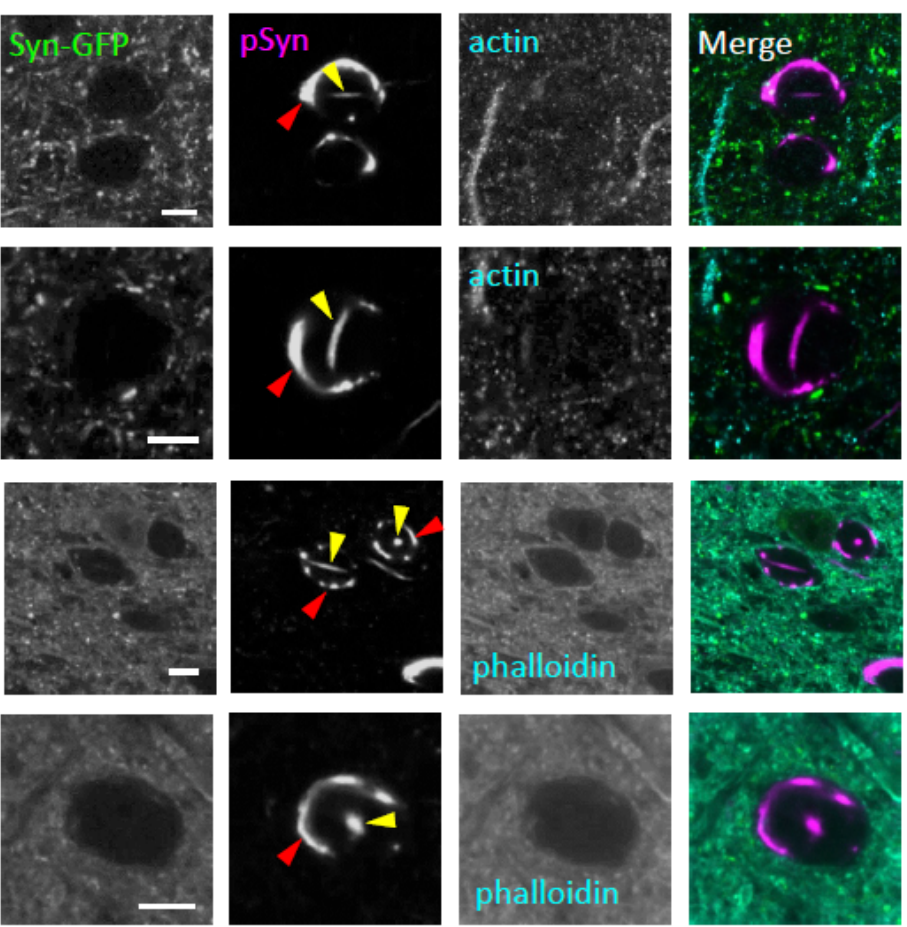
Figure 4. Intranuclear alpha-synuclein aggregates in neurons bearing somatic Lewy pathology do not have an actin component. Confocal imaging in fixed tissue from PFF-injected Syn-GFP transgenic animals induced to form Lewy pathology shows four examples of somatic (red arrowhead) and intranuclear (yellow arrowhead) inclusions (each row a different cell) imaged for endogenous GFP fluorescence (Syn-GFP), with a serine-129 phospho-synuclein antibody (pSyn), an actin-specific antibody ( top two rows ), and the actin-binding dye phalloidin ( bottom two rows ). Scale bars: 5 μ m.